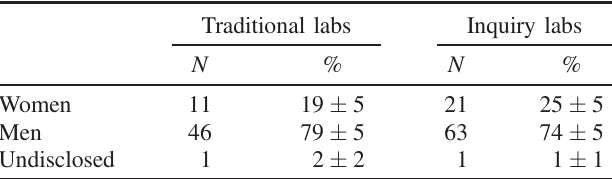
TABLE I. Student demographics of this study. Errors were computed using standard error for population fractions, shown in Eq. (1). In all, 143 students were considered in this